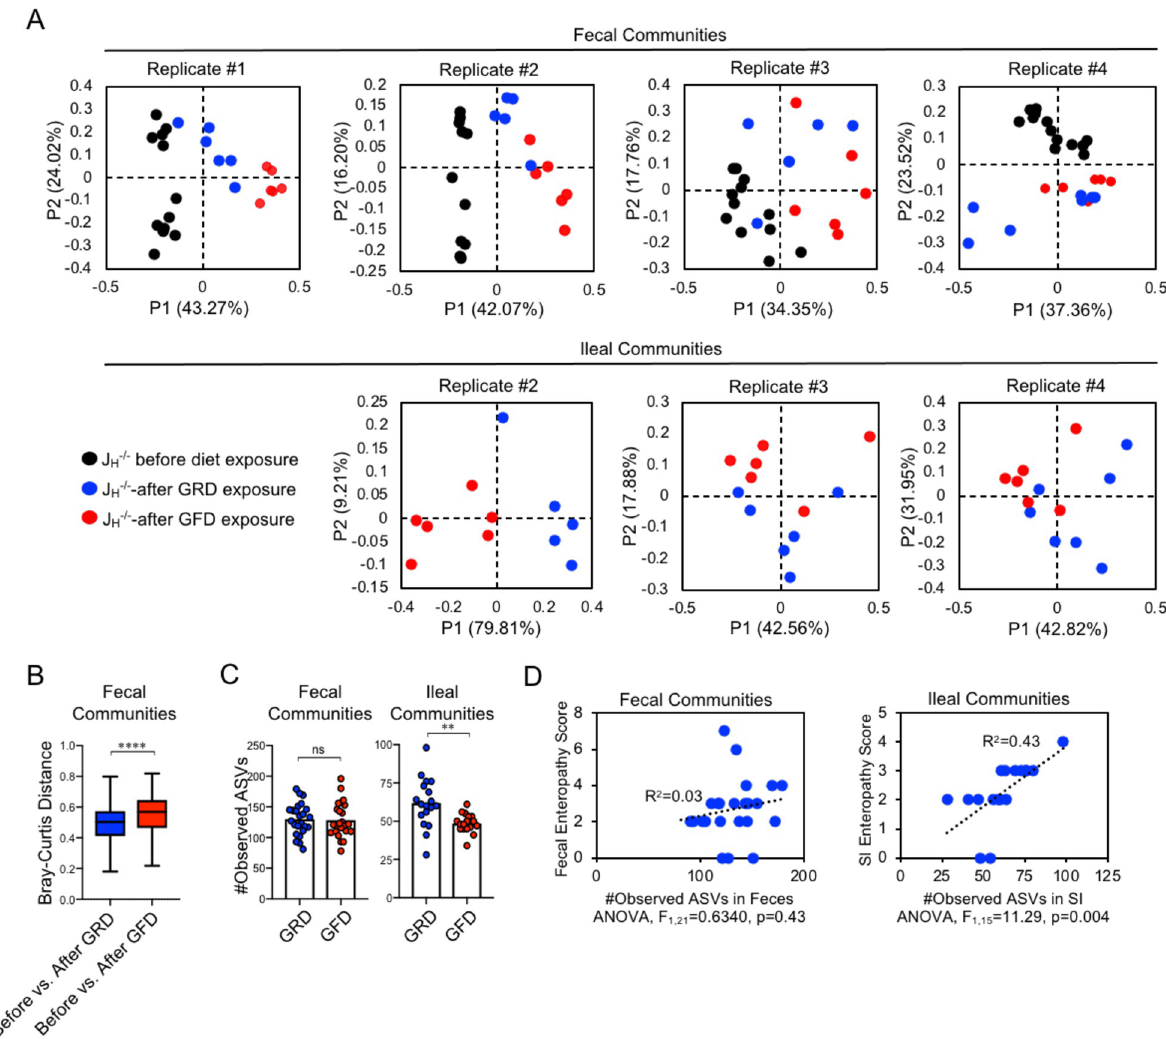
Fig 3. A GFD alters microbiota composition in JH -/- mice. (A) PcoA plots based on Bray-Curtis (BC) analysis of fecal and SI microbial communities across replicate experiments are shown. P-values in plots denote results of PERMANOVA hypothesis testing. (B) Between-group BC distances, reflecting the extent of divergence in microbiota composition before and after diet exposure, are shown. Mann-Whitney U test. (C) The number of observed species (ASVs) is shown between GRD and GFD J H-/- cohorts. Student’s t-test; ns = non-significant, �� = p < 0.01. (D) Results if linear regression analysis of the relationship between species diversity and SI enteropathy scores are shown. One-way